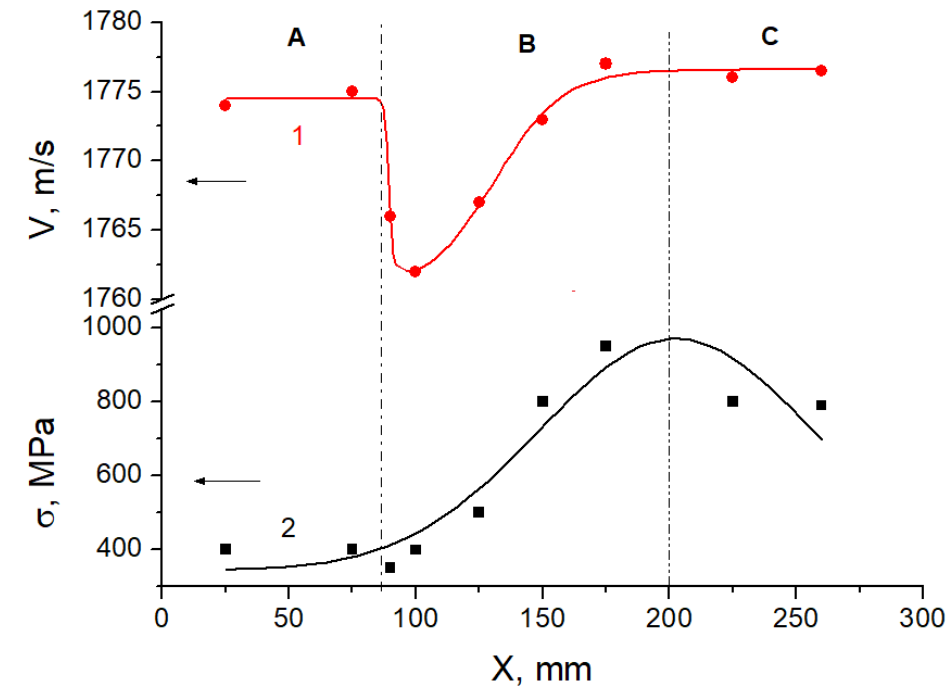
Figure 4. (1) Speed of ultrasound and (2) residual stress at different zones of the cold rolling center. Figure 4. ( 1 ) Speed of ultrasound and ( 2 ) residual stress at different zones of the cold rolling center. The zone designations are the same as in Figure The zone designations are the same as in Figure 1.